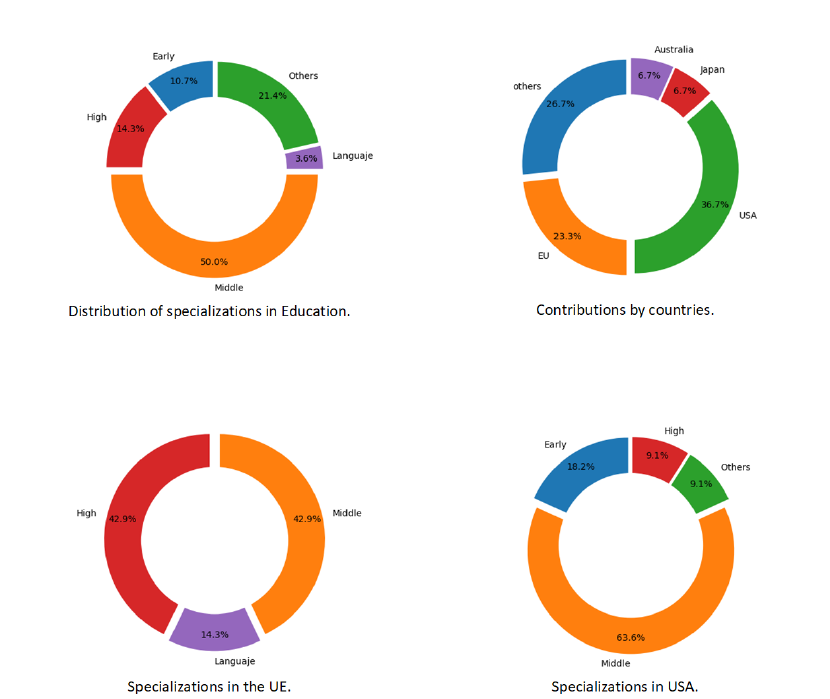
Figure 12. Information about publications on education: in the top left image is the percentage of publications analyzed in education. In the top right is the percentage of publications made by countries. In the bottom left is the publications made in the EU, and in the right bottom is the information of publications made in the USA.